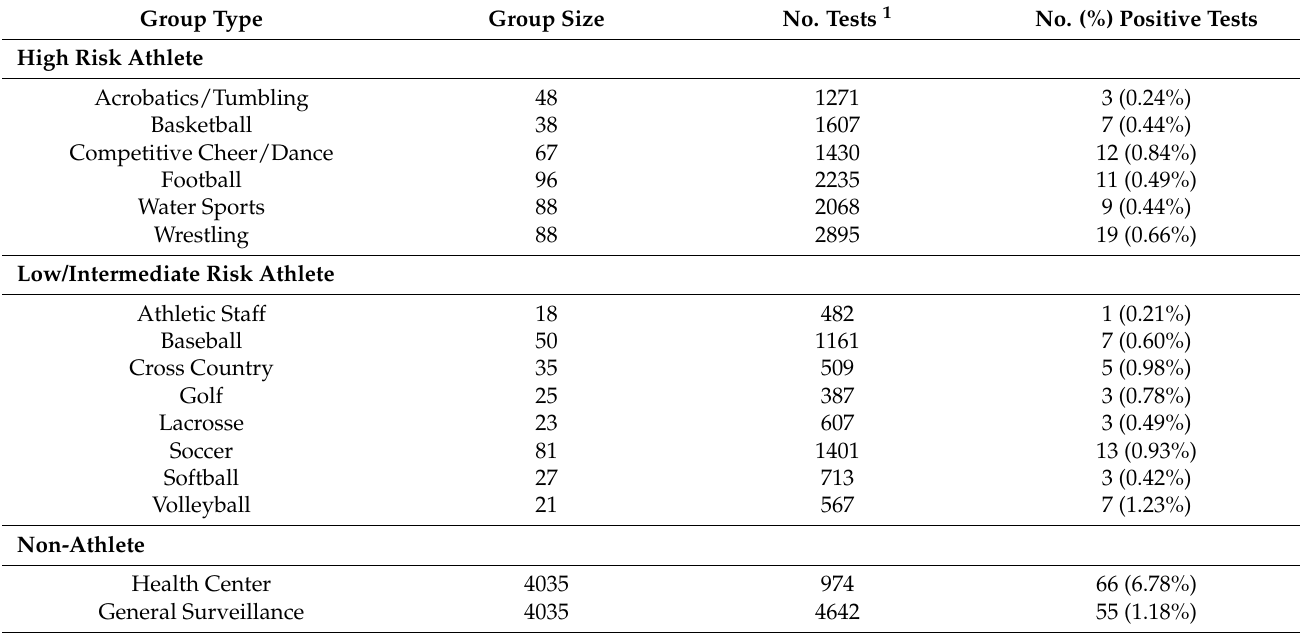
Table 2. Characteristics of SARS-CoV-2 surveillance of athlete and non-athlete group types at Gannon University, Erie, Pennsylvania Campus, during the 2020/2021 academic